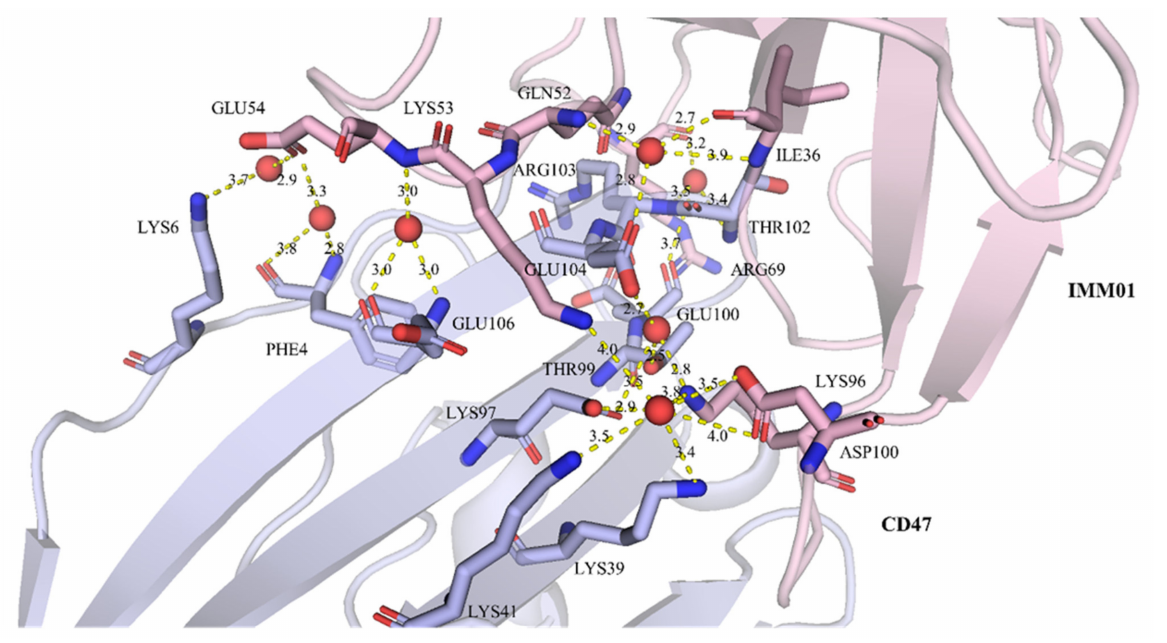
Figure 7. Water-bridged hydrogen bond interactions between chain A (IMM01) and chain C (CD47). Chain A and chain C are shown in pink and light blue, respectively. The residues forming hydrogen bond with waters are shown as sticks, and the water molecules are shown as red spheres. Key hydrogen bonds are highlighted as yellow dashed lines.